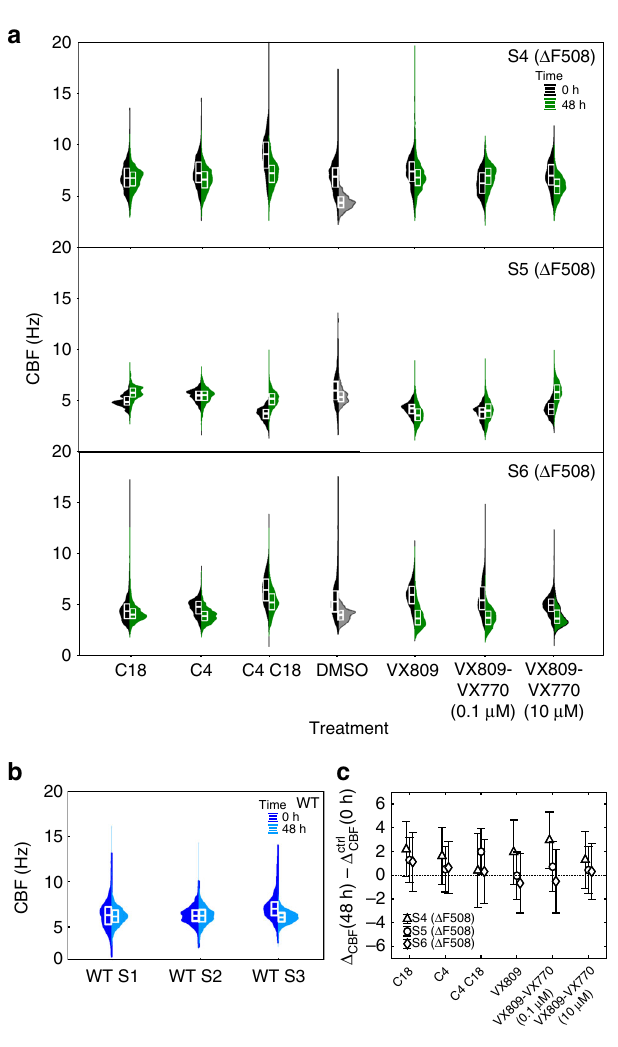
Fig. 4 CFTR-modulating drugs yield a relative increase in CBF. a Split violin plots showing CBF distribution before (black) and after (green) a 48-h period in which CFTR-modulating drugs were administered to samples from subjects affected by CF ( Δ F508/ Δ F508). Each distribution pools CBF data from up to 20 FOVs across the sample. b Split violin plots showing CBF distribution measured on samples from three different healthy donors. c Change in CBF after 48 h treatment compared to the change in CBF of the DMSO control over the same amount of time. The CFTR-modulating compounds increase the CBF compared to the DMSO control in all but three cases. Markers show the average value, error bars are obtained by propagating the SD of the individual CBF distributions. Each marker, with its error bars, pertains to a single subject. All data are from nasal HAECs